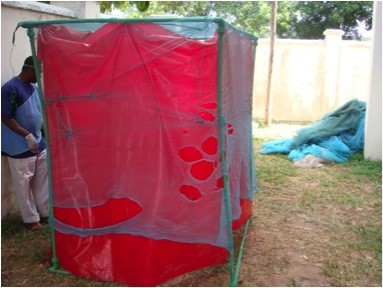
Damaged LLINs being examined on a plastic frame showing distribution of large holes (>5 cm) and knots as a method of net repair.